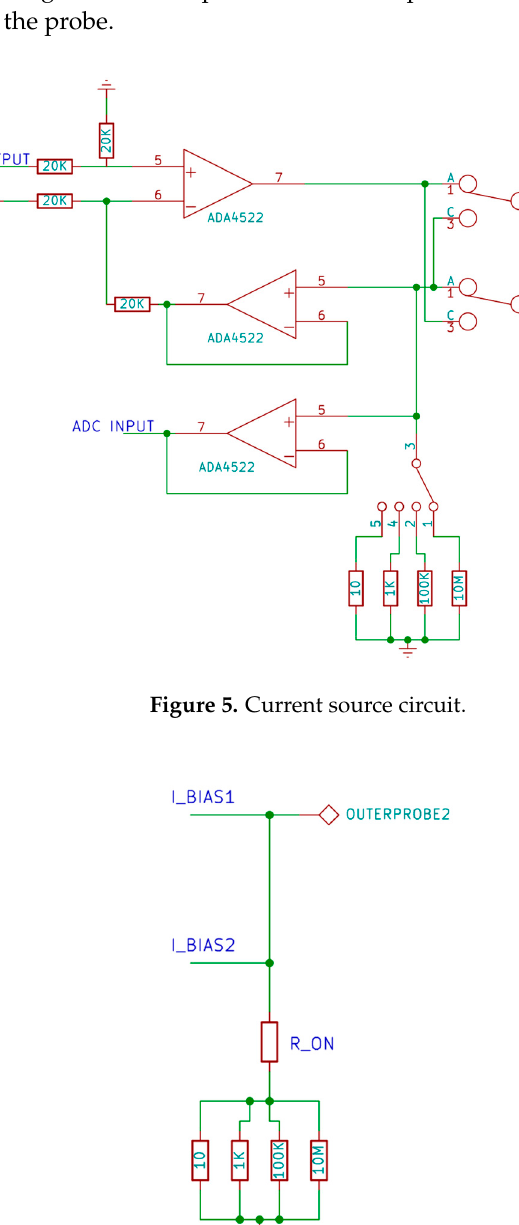
Figure 6. Parasitic resistance and leakage of current source circuit.